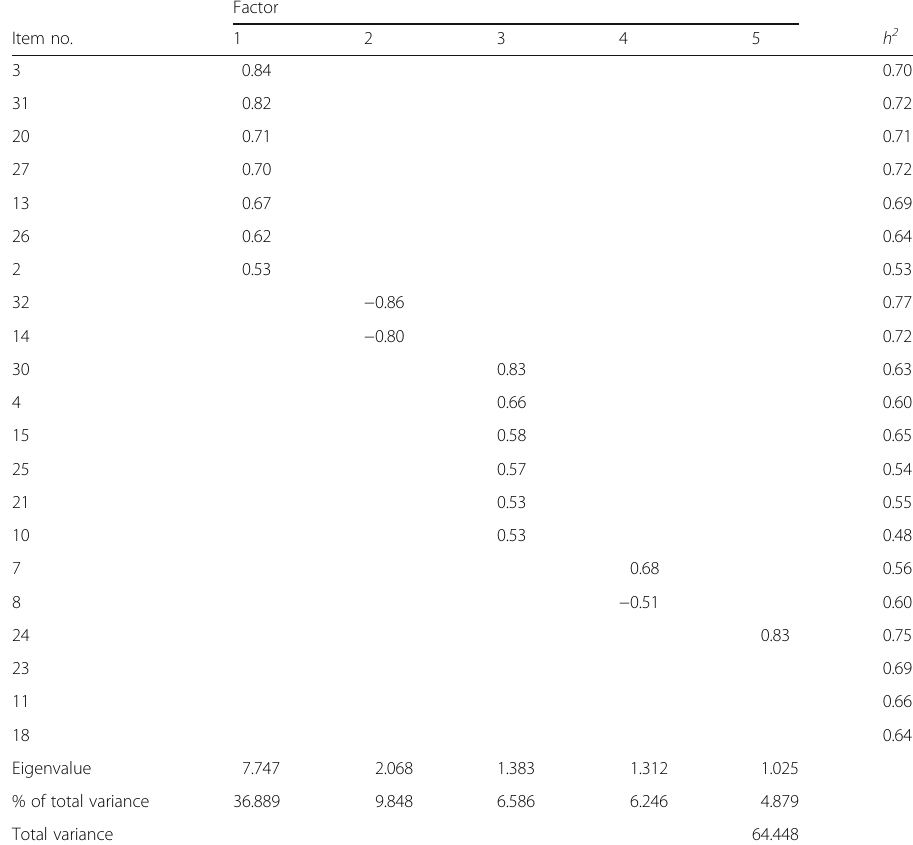
Table 4 Results of the second exploratory factor analysis of the FLCAS with direct oblimin rotation ( n = 149) Factor Item